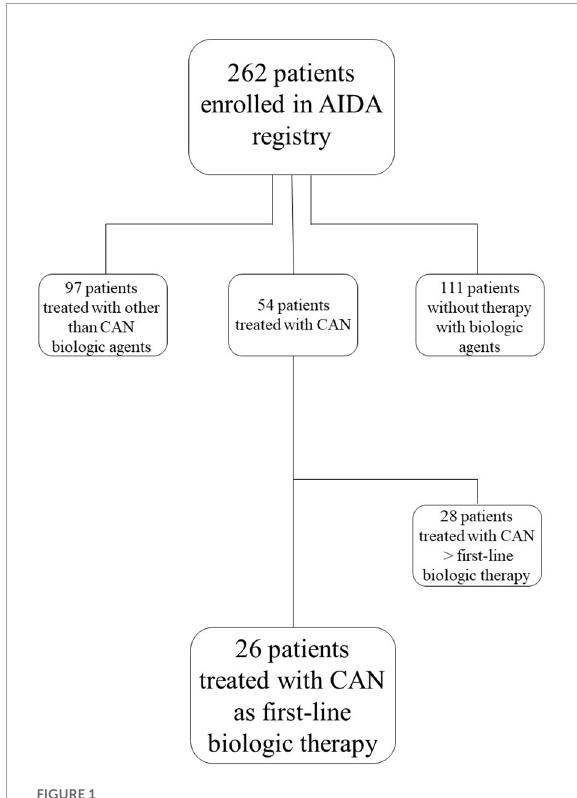
FIGURE1 Study flow diagram illustrating the process leading to the selection of patients included in the present study among all patients recruited in the international AutoInflammatory Disease Alliance (AIDA) Registry dedicated to Still’s disease. AIDA, AutoInflammatory Disease Alliance; CAM,